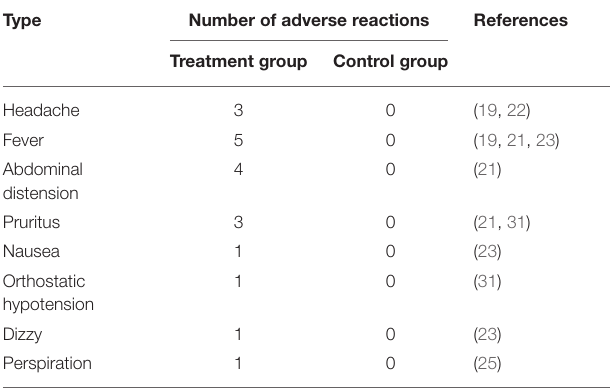
TABLE 7 | Incidence rate of adverse